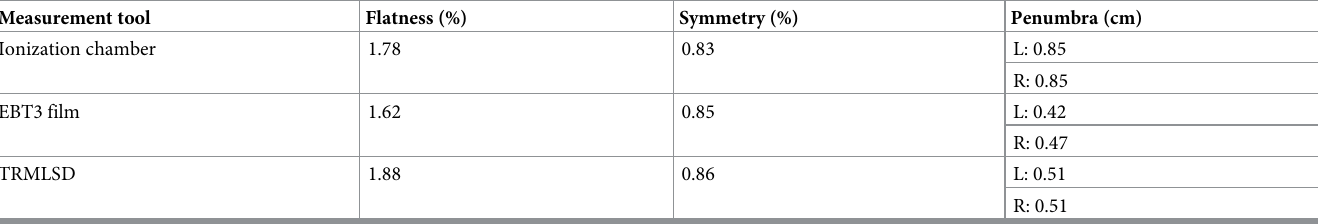
Table 2. Beam profiles of 6 MV X-rays for a 5.0-cm-thick solid water phantom. Measurement